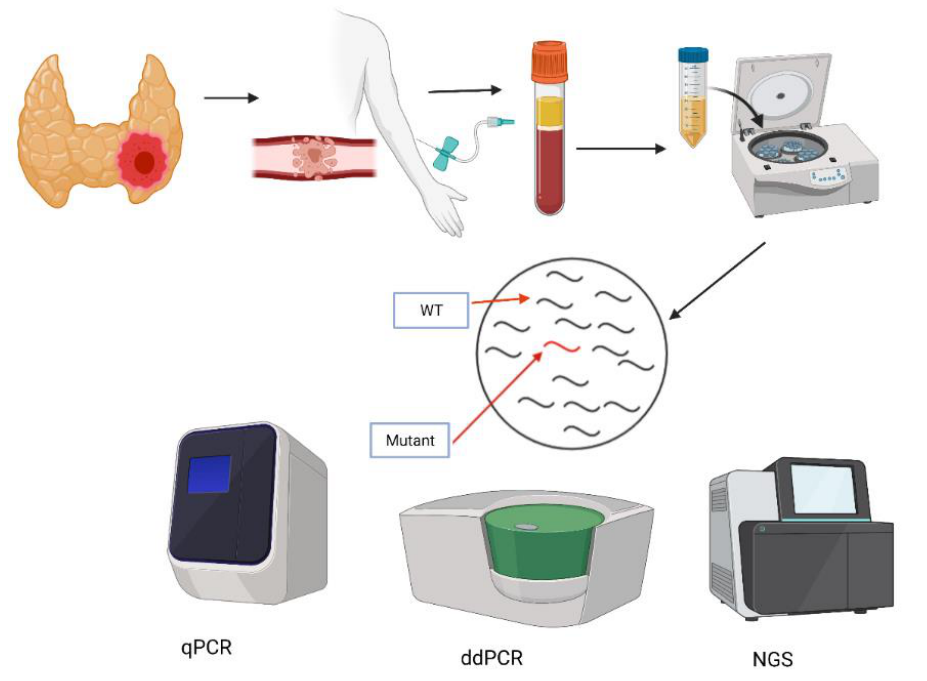
Figure 1. Detection techniques for liquid biopsies. (Created with BioRender.com, accessed on 2 March 2021.) Peripheral blood samples are collected and centrifuged to separate plasma from whole blood. DNA and RNA are extracted from plasma. Targeted mutation screening can be undertaken using Real-Time PCR (qPCR) and digital droplet PCR (ddPCR). Next-generation sequencing (NGS) allows for the screening for unknown mutations.